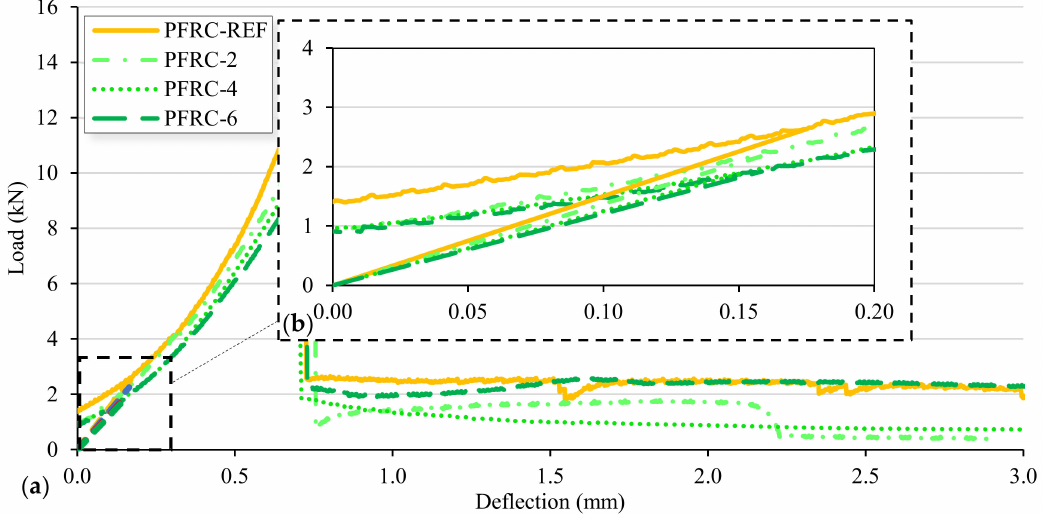
Figure 6. Load–deflection curves of each concrete type ( a ); detailed view of the initial section of the curve ( b